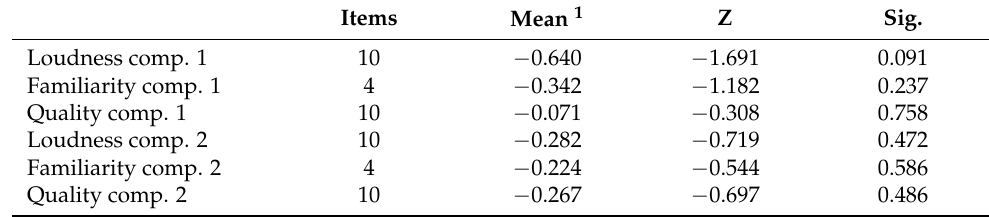
Table 4. Comparative perceptual rating of audio samples between PD and AD